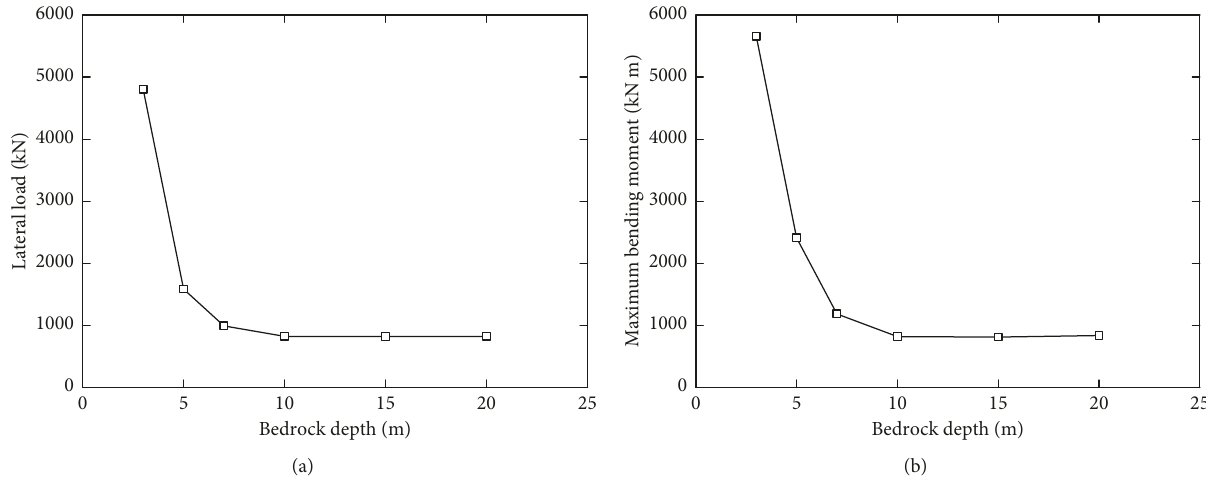
Figure 7: Effect of bedrock depth on (a) the required lateral load and (b) the maximum bending moment for a pile head displacement of 38mm.